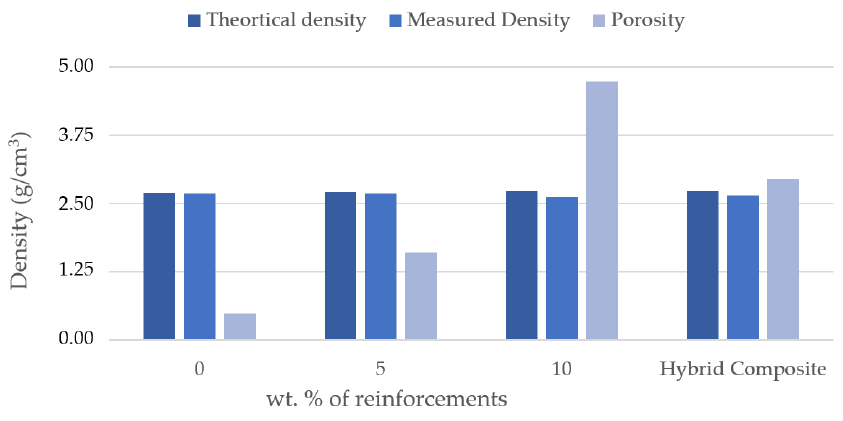
Figure 4. Density (theoretical and measured) and porosity of the specimen.